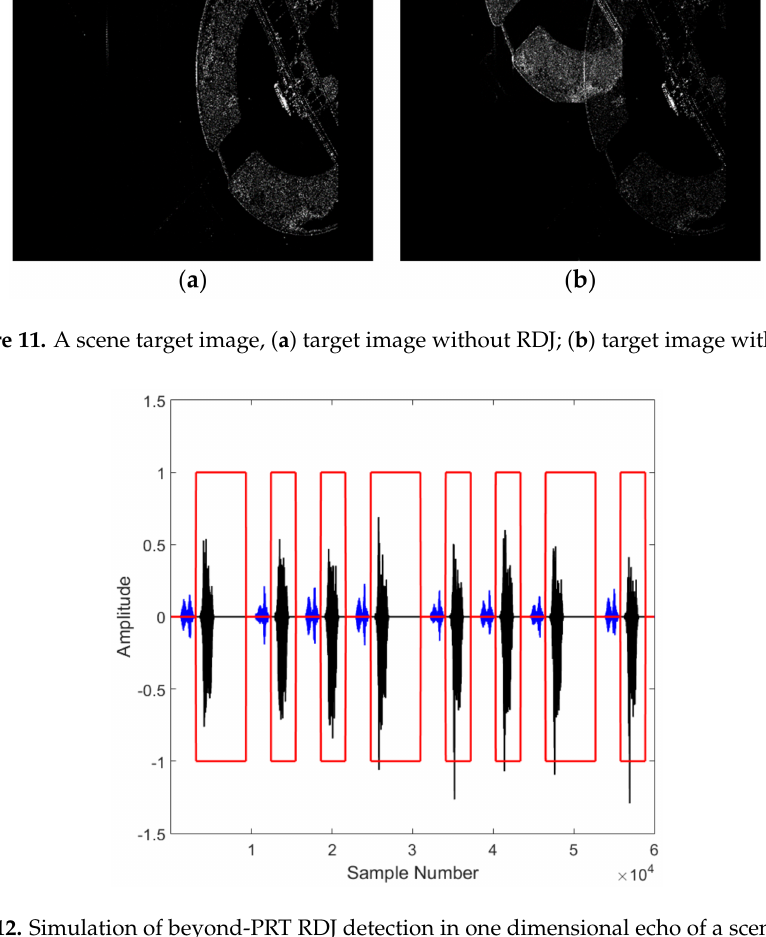
Figure 12. Simulation of beyond-PRT RDJ detection in one dimensional echo of a scene